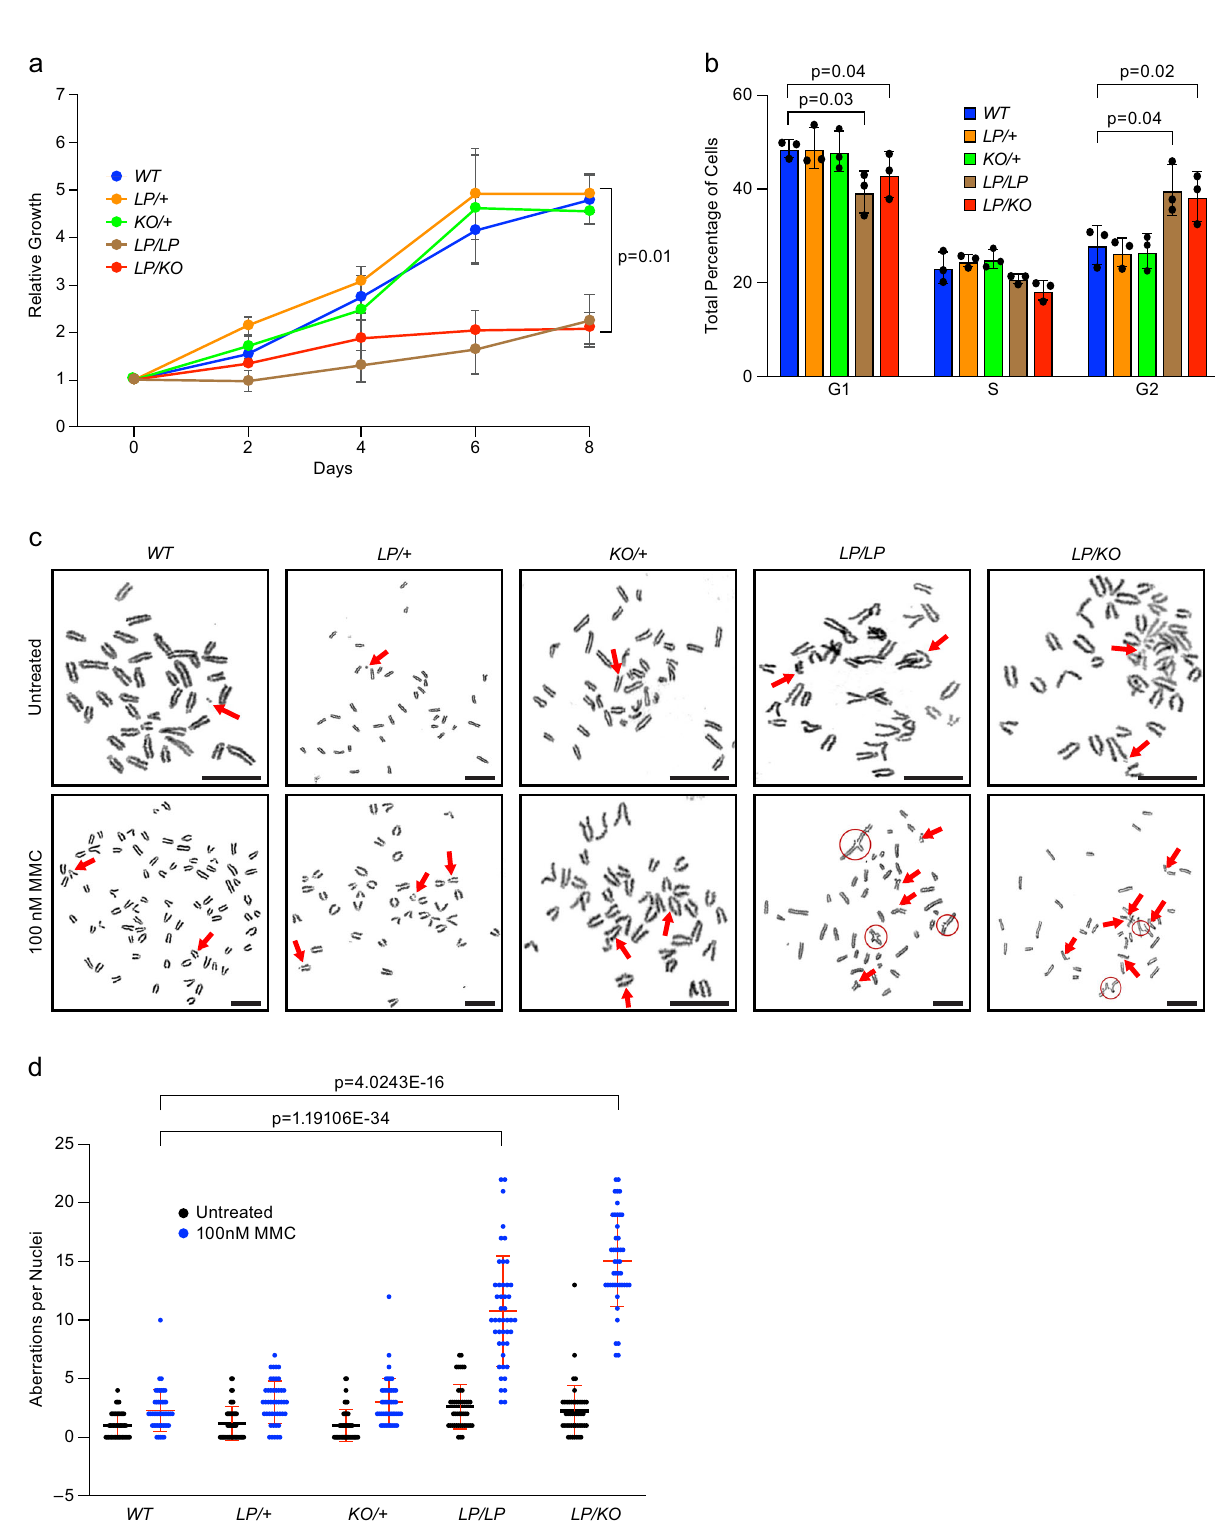
Fig. 3 Brca2 L2431P mutant MEFs exhibit genomic instability. a Growth curve of MEFs of different genotypes over 8 days. LP/LP and LP/KO MEFs have reduced relative growth compared to controls ( n = 3 biological replicate, one-tailed t-test: two-sample assuming unequal variances, error bar- SE of mean). b Cell cycle analyses of MEFs of indicated genotypes shows LP/LP and LP/KO MEFs get stalled in G2 phase ( n = 3 biological replicate, two-tailed Student ’ s t test, error bar- SD of mean). c Chromosomal aberrations in MEFs of indicated genotype, untreated (top panels) and after 100 nM MMC treatment (lower panels). Aberrations are marked with red arrows and radials are circled (scale bar = 5 μ m). d Quanti fi cation of chromosomal aberrations in MEFs shown in c . LP/LP and LP/KO MEFs exhibit increased number of chromosomal aberrations after treatment as compared to WT ( n = 3 individual MEFs with 15 nuclei each making 45 nuclei in total, two-tailed Student ’ s t test, error bar- SD of